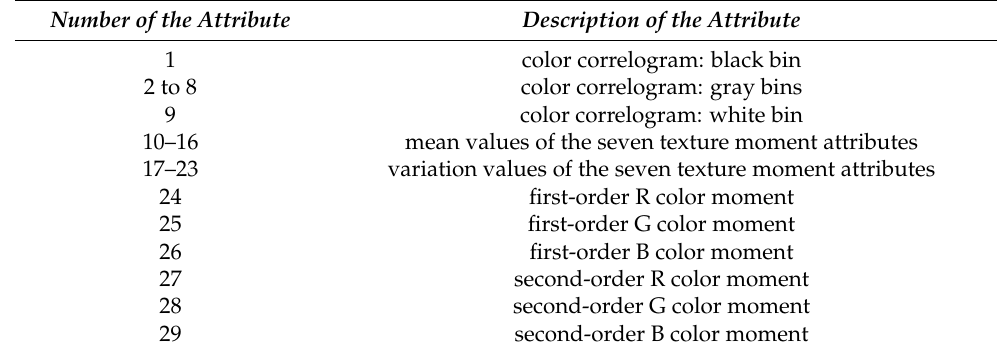
Table 1. The encoding with the 29 attributes and their positions. Number of the Attribute Description of the